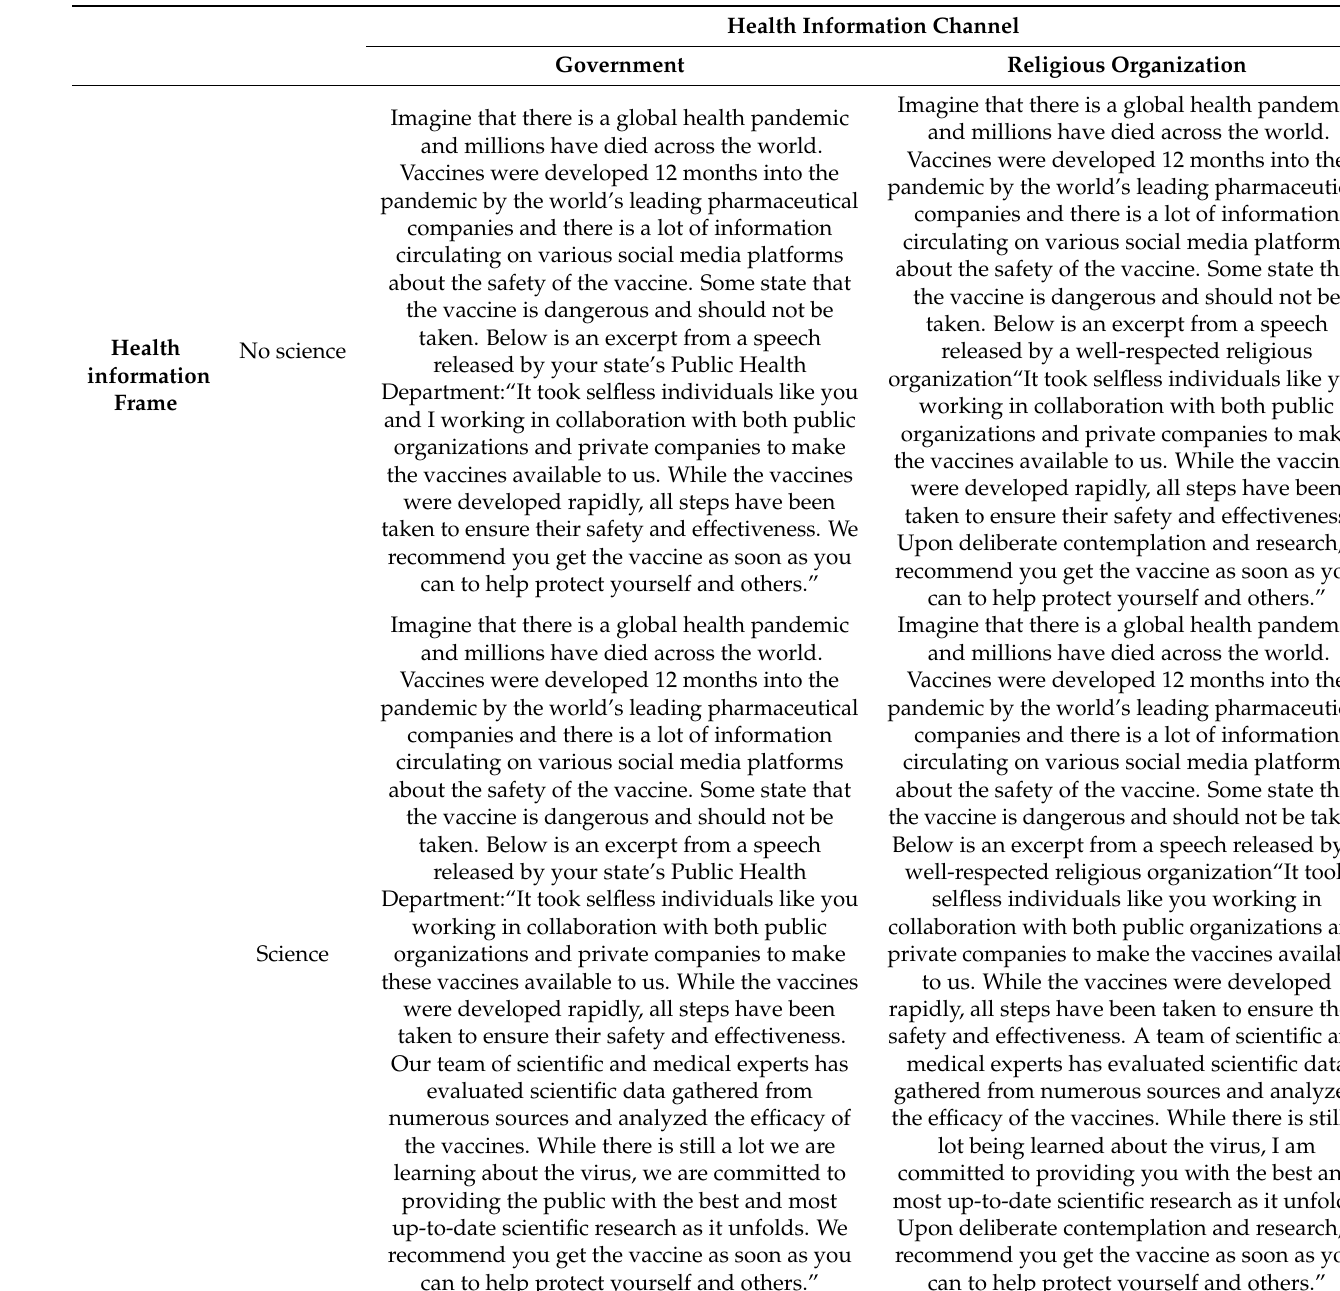
Table A1. Experimental vignettes administered to respondents.